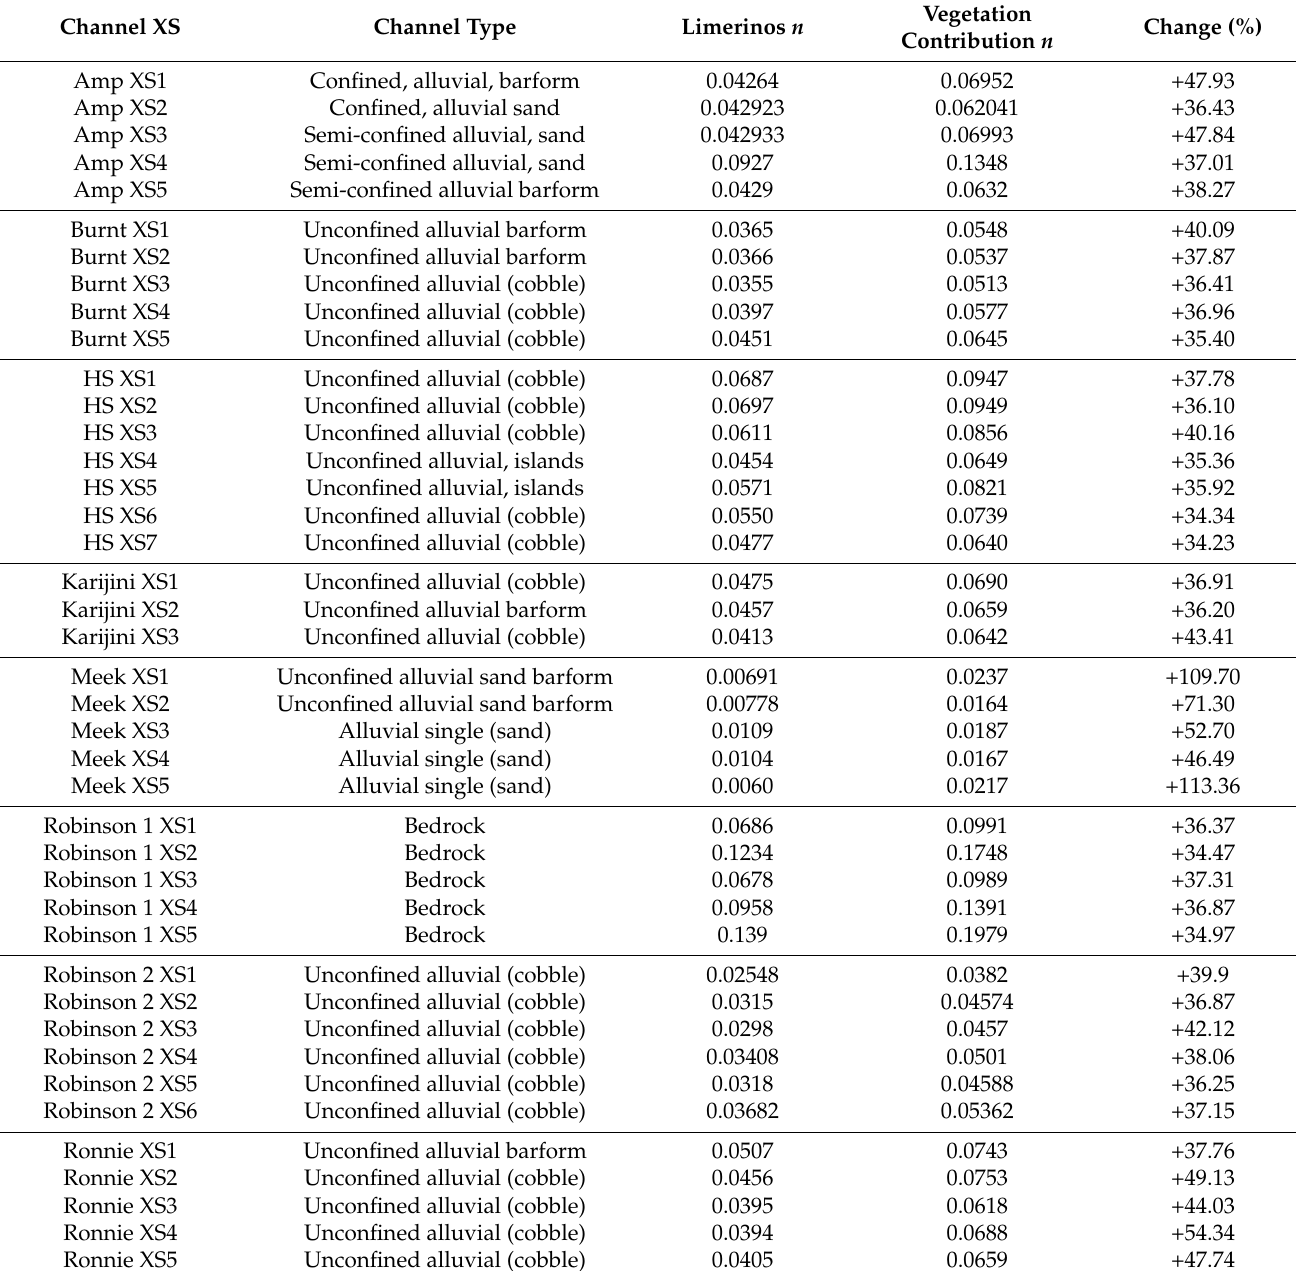
Table 7. Contribution of in-channel vegetation to overall channel roughness in surveyed river reaches.